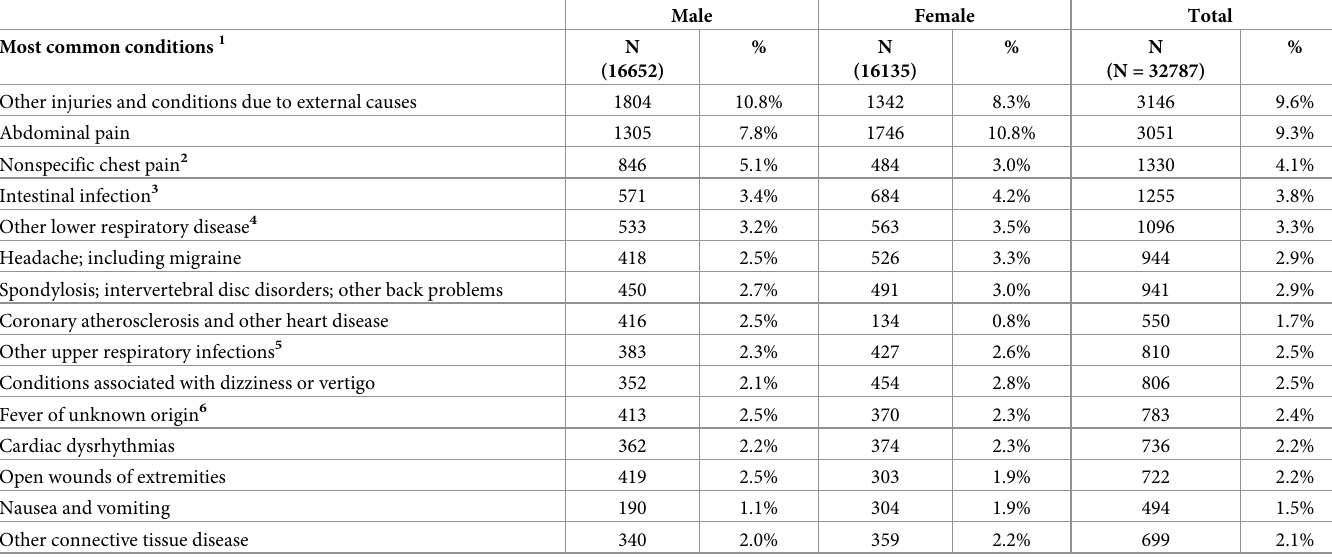
Table 3. Top most common reasons for all ED visits for